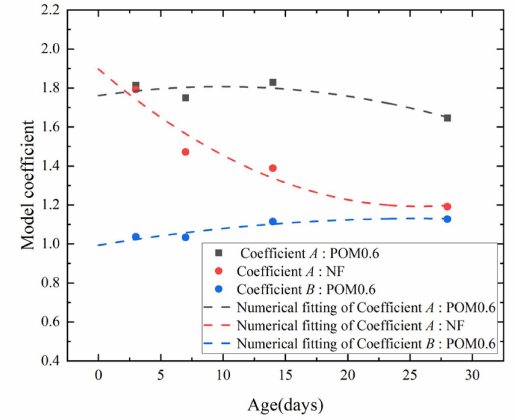
Figure 28. Model coefficients of POM and NF SWSSC with different